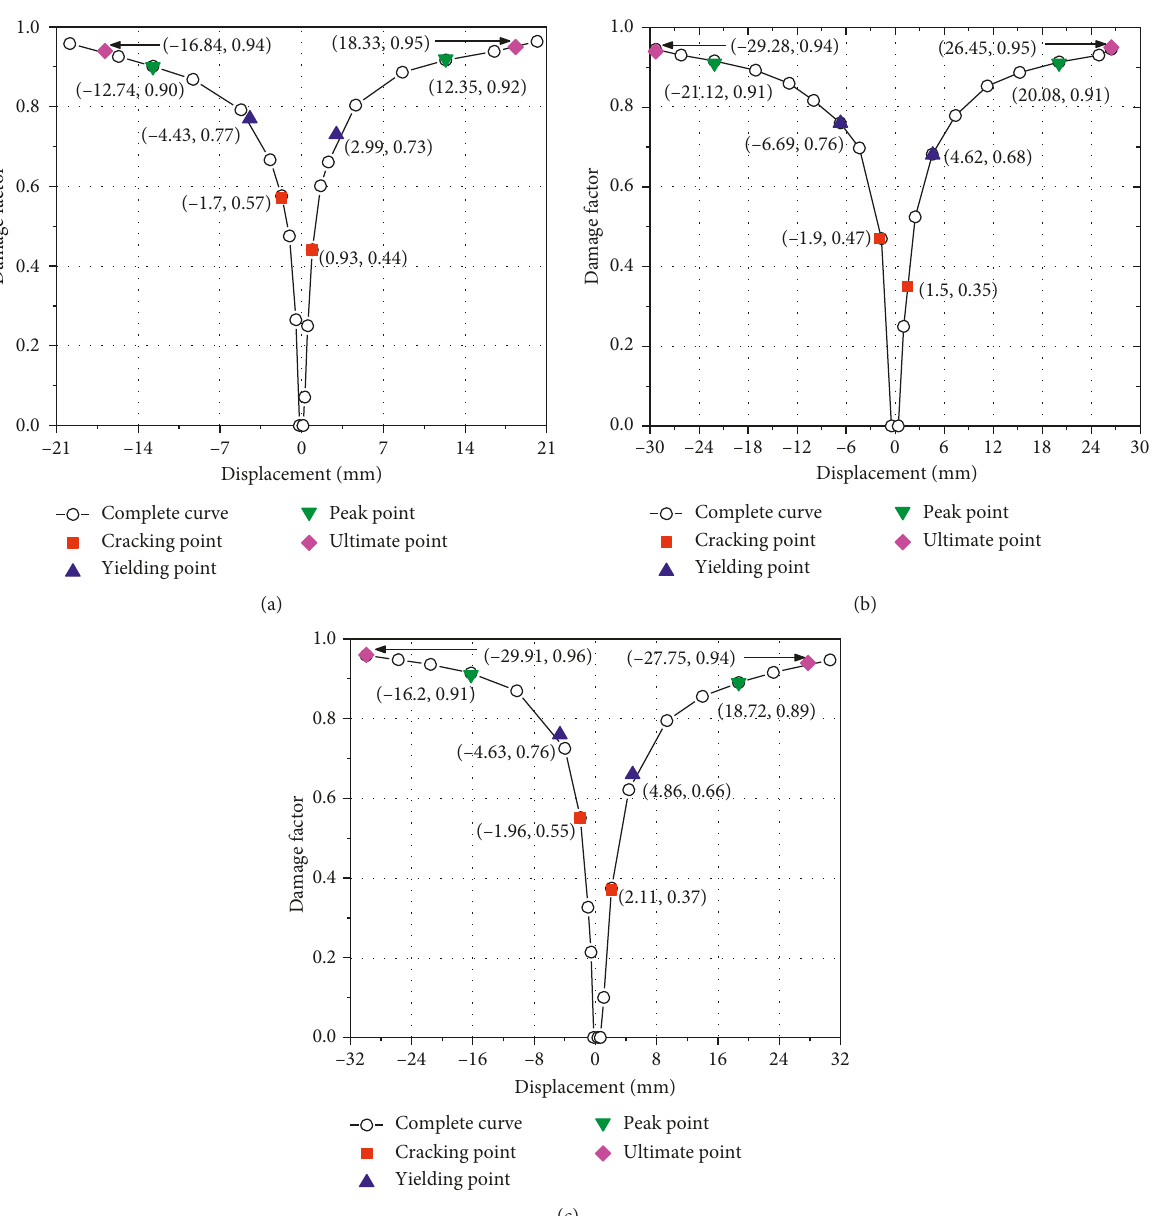
Figure 20: The damage factors of the test specimens: (a) SW1, (b) SW2, and (c)